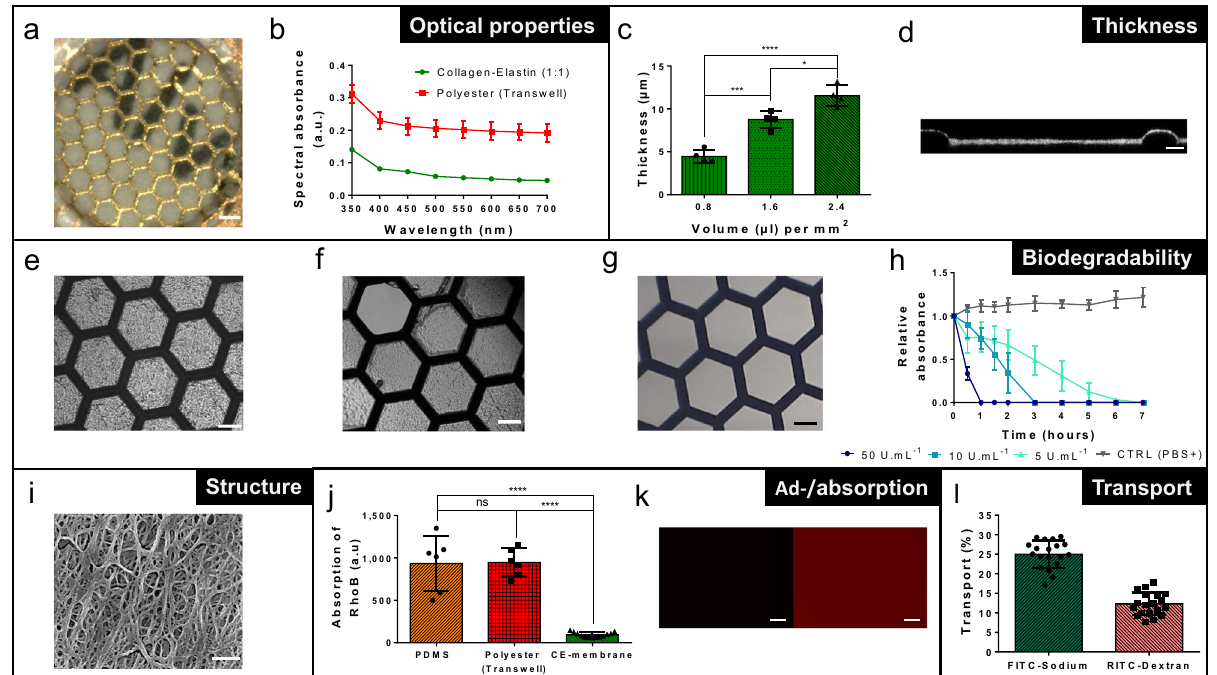
Fig. 2 Properties of the thin biological membrane. a Optical clarity of a 10- µ m-thin CE membrane integrated in the gold mesh. Scale bar: 200 µ m. b Comparison of the spectral absorbance of the CE membrane ( n = 4) and of a polyester membrane (Transwell insert 0.4 µ m pores sizes) ( n = 3). c Characterization of the CE-membrane thickness in function of the collagen – elastin solution volume pipetted on top of the gold mesh ( n = 4). d Cross- section of the CE membrane visualized via confocal microscopy. Scale bar: 20 µ m. e Picture of an array of several hexagons with a CE membrane. Scale bar: 100 µ m. f Local disruption (top left hexagon) of a membrane after being exposed to 10 U mL − 1 MMP-8 in PBS + during 1 h and stretched at − 2 kPa. Scale bar: 100 µ m. g Totally disrupted membrane after being exposed during 1 h to 50 U mL − 1 of MMP-8 in PBS + . Scale bar: 100 µ m. h CE-membrane degradation in function of the time and of the MMP-8 concentrations at 550 nm ( n = 4). i SEM picture of the collagen and elastin fi bers of the CE membrane. Scale bar: 500 nm. j Difference of rhodamine B (10 µ M) absorption between a 10- µ m-thin CE membrane ( n = 13), a 10- µ m-thin PDMS membrane ( n = 6) and a polyester porous membrane (Transwell insert, 0.4 µ m pores sizes) ( n = 6). k Pictures of CE membrane (left) and a PDMS membrane (right) after being exposed to RhoB for 2 h. Scale bar: 200 µ m. l Transport of FITC – sodium and RITC – dextran molecules across the CE membrane ( n =